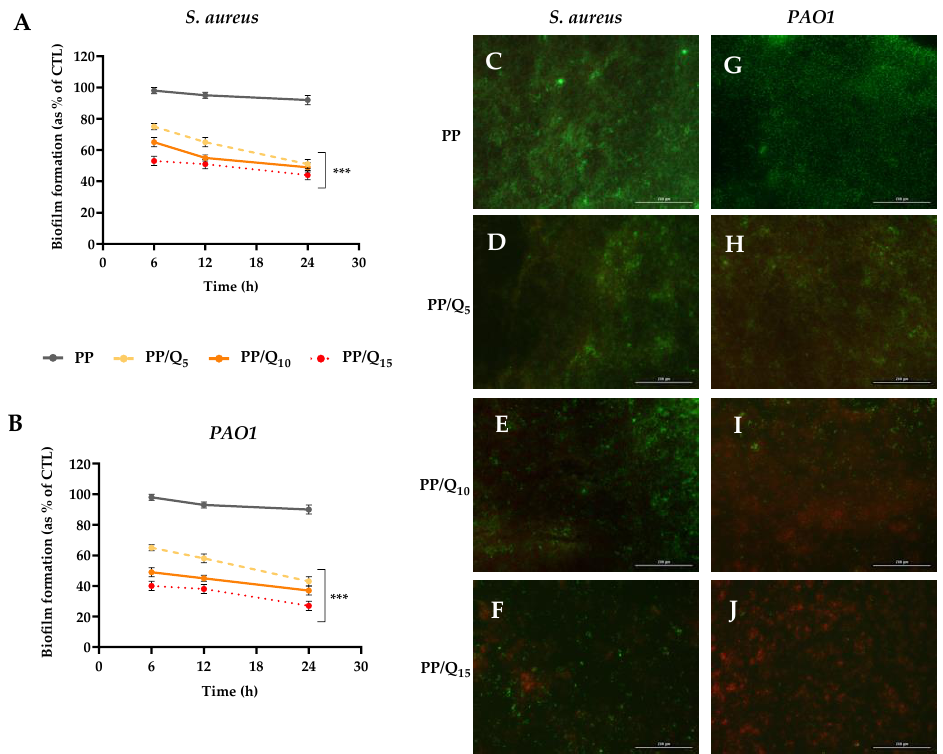
Figure 4. Antibiofilm activity of QUE-loading membranes. Biofilm formation was evaluated by CV assay, after 6, 12, and 24 h of incubation at 37 °C in presence of S. aureus ( A , B ) PAO1 as described in the material and methods section. Biofilm formation was reported as a percentage in comparison with to the maximum amount of biofilm produced by S. aureus and PAO1 grown (bacterial positive controls). For each sample, six different experiments were conducted, and the results expressed as the mean of the values obtained (mean ± SD). Statistically significant variations: *** p < 0.001 versus PP. ( C – J ) Fluorescent microscopy images of live/dead staining (scale bar 200µm, 40X magnification) of S. aureus ( C – F ) and PAO1 ( G – J ) on PP ( C , G ), PP/Q 5 ( D , H ), PP/Q 10 ( E , I ) and PP/Q 15 ( F , J ). Live bacteria were stained in green, and dead bacteria were stained in red. Live and dead bacteria in proximity resulted in yellow/orange color.